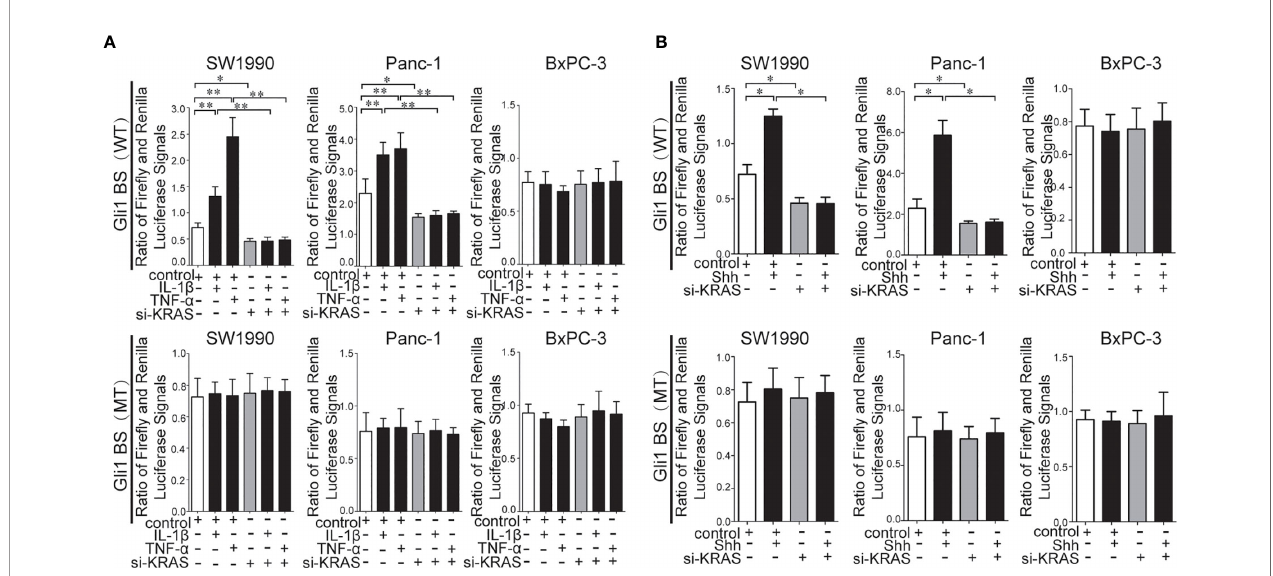
FIGURE 4 | Results of the pGL3-8×Gli1 BS luciferase reporter assay in the MT-KRAS cells (SW1990 and Panc-1) and WT-KRAS cells (BxPC-3) after treatment with: IL-1 b , TNF- a alone or in combination with si-KRAS transfection (A) . Shh alone or in combination with si-KRAS transfection (B) . All data were obtained in three independent experiments. *p < 0.05; **p <